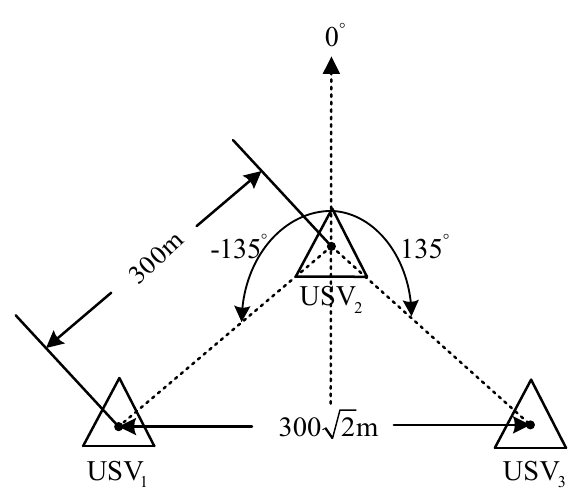
Figure 30. Schematic diagram of the expected formation for the USV.